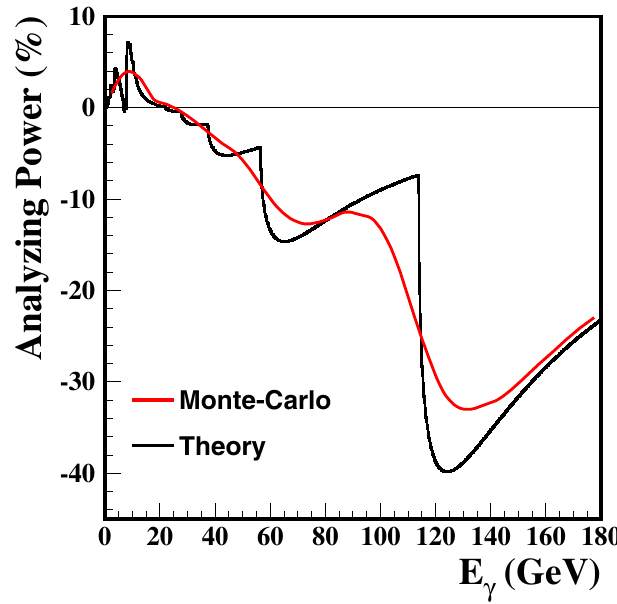
(black curve) for an (cid:1)